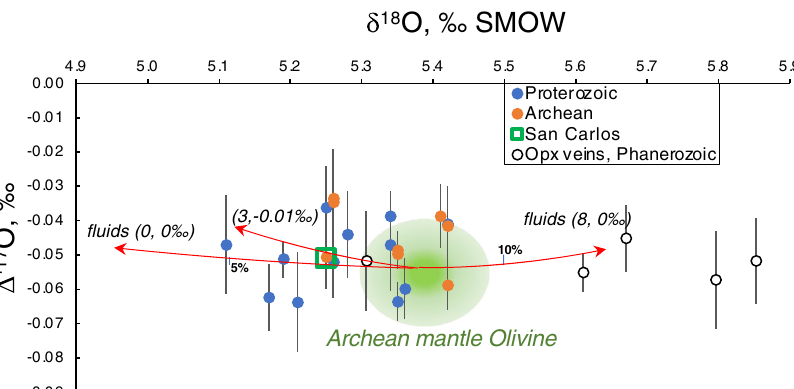
Fig. 4 Triple oxygen isotope analyses of Archean and post-Archean olivines and orthopyroxenes showing overlap with San Carlos olivine. Expected trends to higher- Δ ′ 17 O and lower and higher δ 18 O subduction fl uids, derived from subducting slabs are shown. The δ 18 O in orthopyroxenes is higher than equilibrium olivine by 0.5 – 0.7 ‰ and nearly identical in Δ ′ 17 O at mantle temperatures (Fig. 3, ref. 66